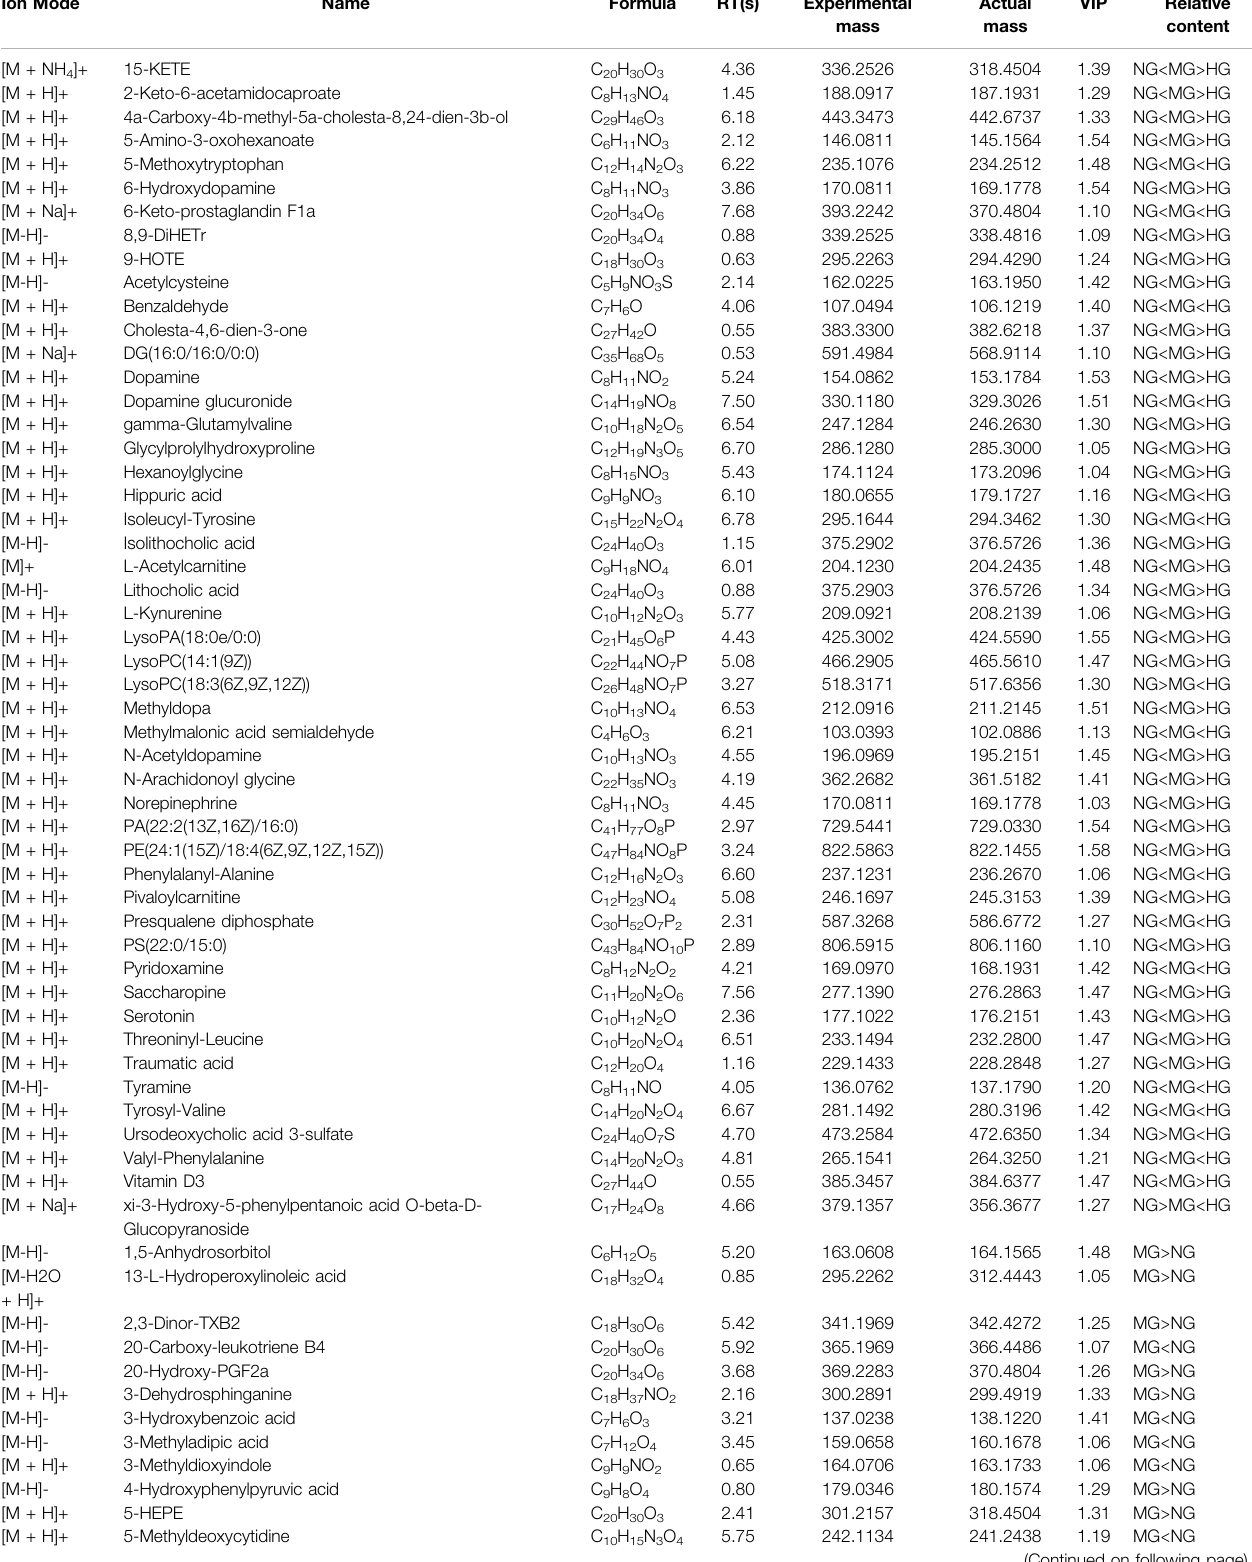
TABLE1 | Identi fi cation of potential biomarkers of rat fecal samples. Ion